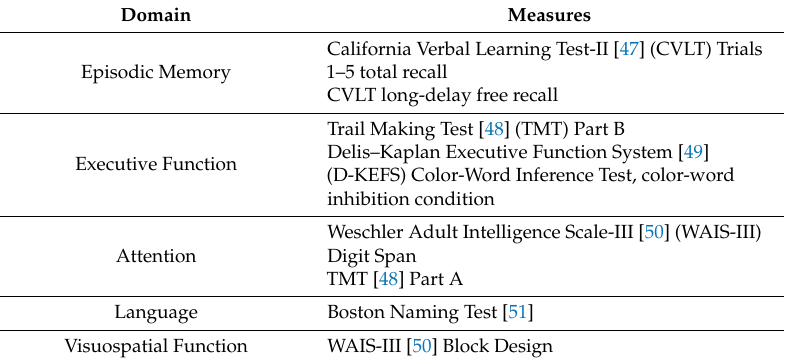
Table 1. Neuropsychological measures used in the actuarial neuropsychological criteria for classifying